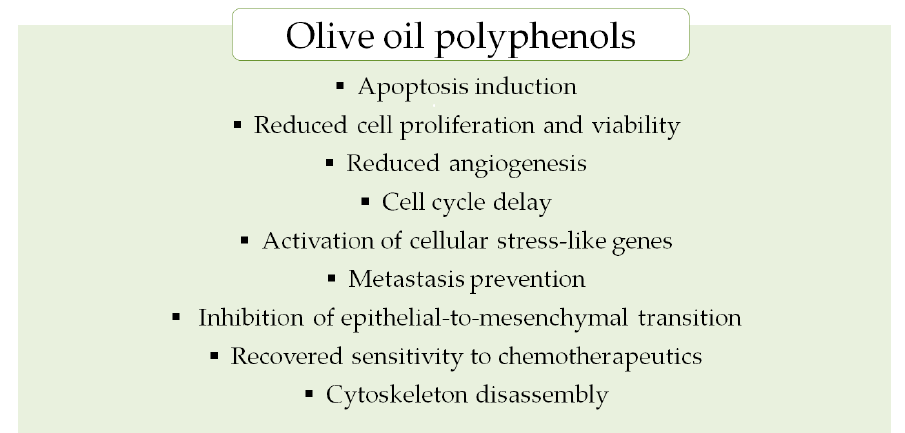
Figure 3. Anticancer effects of olive oil polyphenols [115].